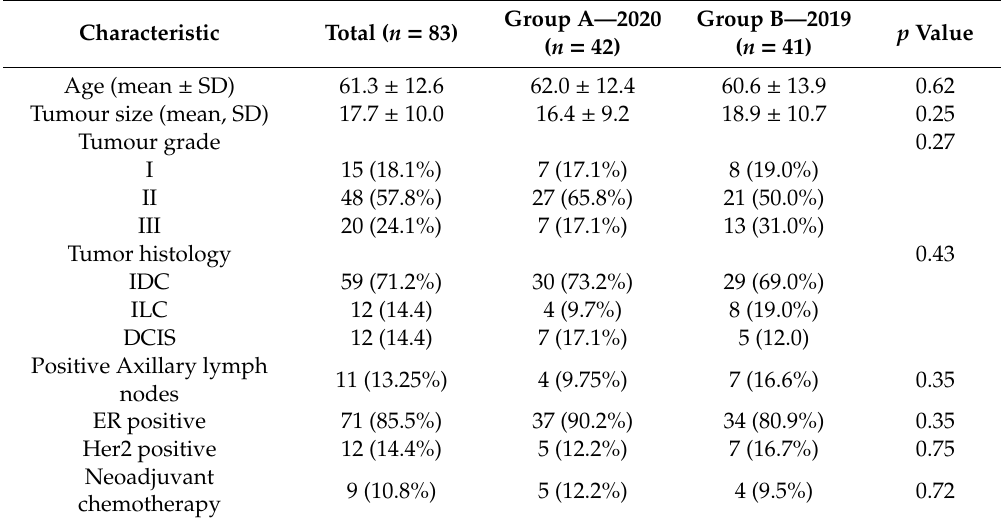
Table 1. Demographic and clinicopathological characteristics of the study